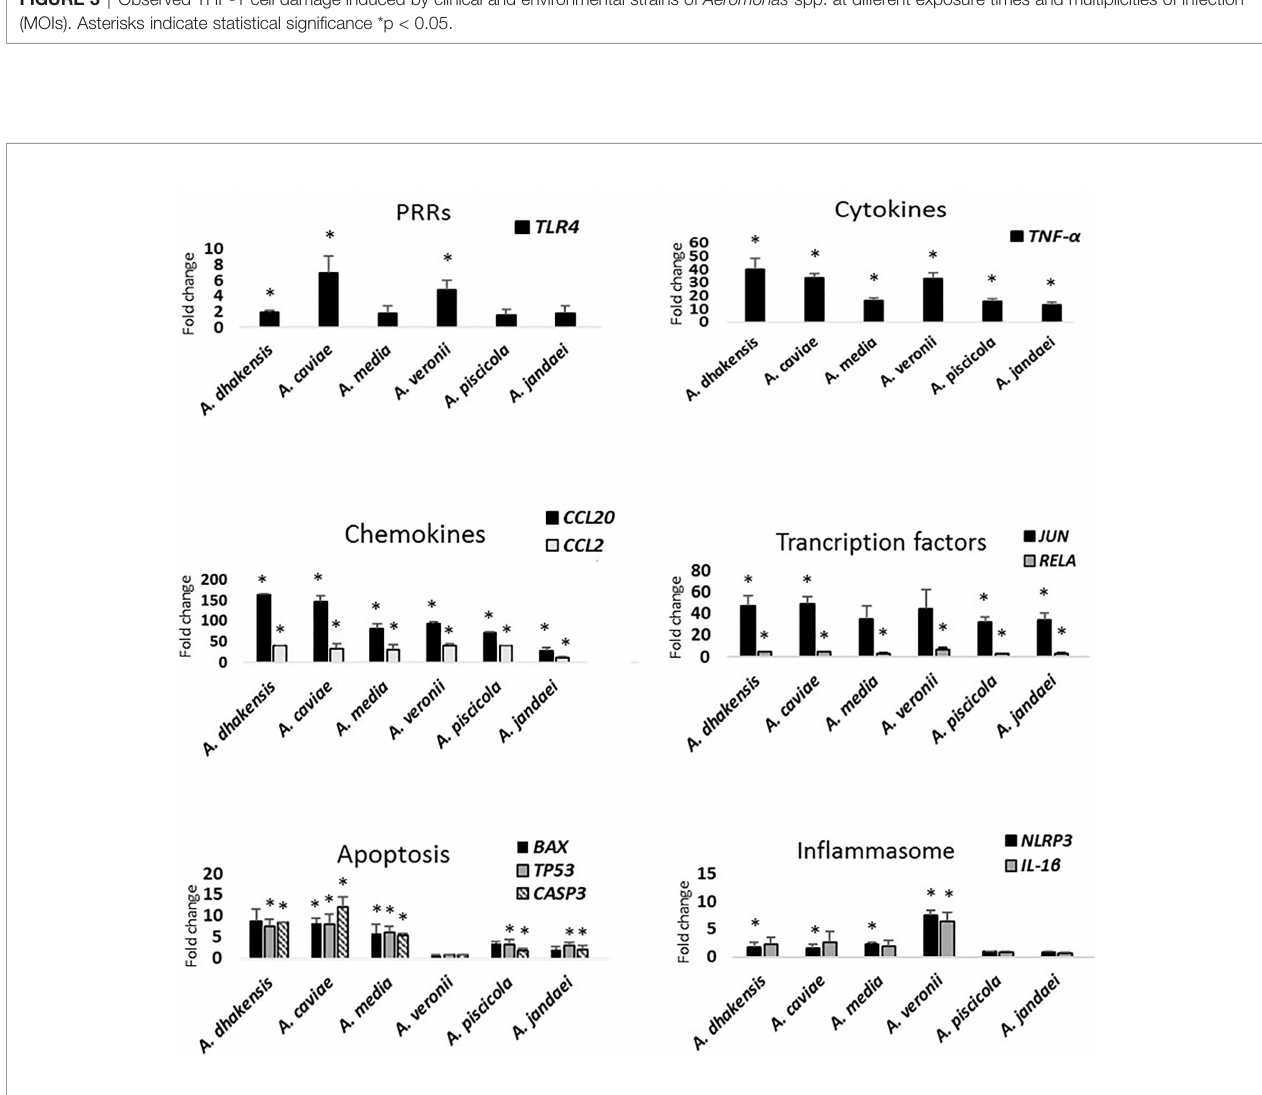
FIGURE 4 | Gene expression pro fi le of THP-1 cells in relation to the non-infected cells induced by the different studied Aeromonas spp. at multiplicity of infection (MOI) 20 determined by RT-qPCR. Transcript levels of the genes were normalized to the expression of GAPDH gene. Expression fold change with respect to the non-infected cells was calculated using the comparative DD Ct method. Asterisks indicate statistical signi fi cance *p < 0.05.